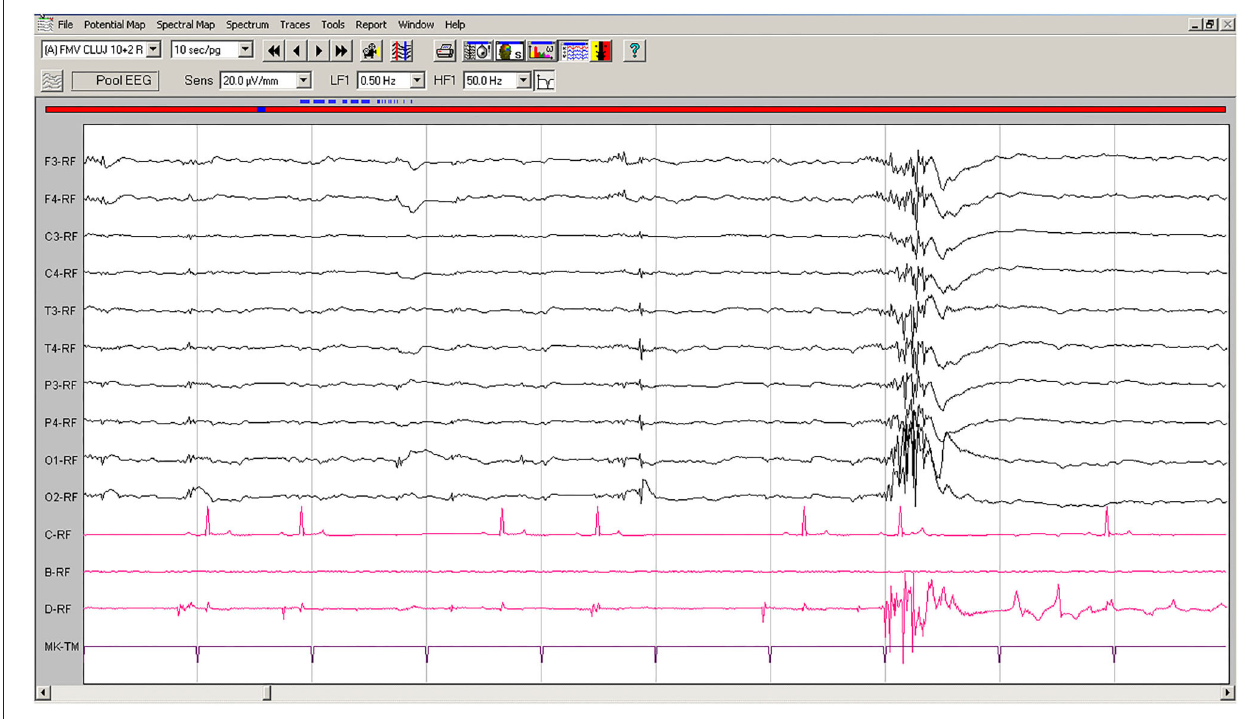
FIGURE 1 | Spontaneous EEG recording of Case No. 1 patient (8-years old male Beagle): Polyspike-slow wave complexes of varying amplitude are seen on all derivations, accompanied by sudden myoclonic contraction of the neck and forelimbs. Low-cut filter: 0.5Hz; high-cut filter: 50Hz; speed 10 sec/page; channel C: ECG, bipolar on the chest; channel B: empty; channel D: bipolar, right brachiocephalic muscle. Figure shown at 20 µ V/mm. EEG, electroencephalogram; ECG,